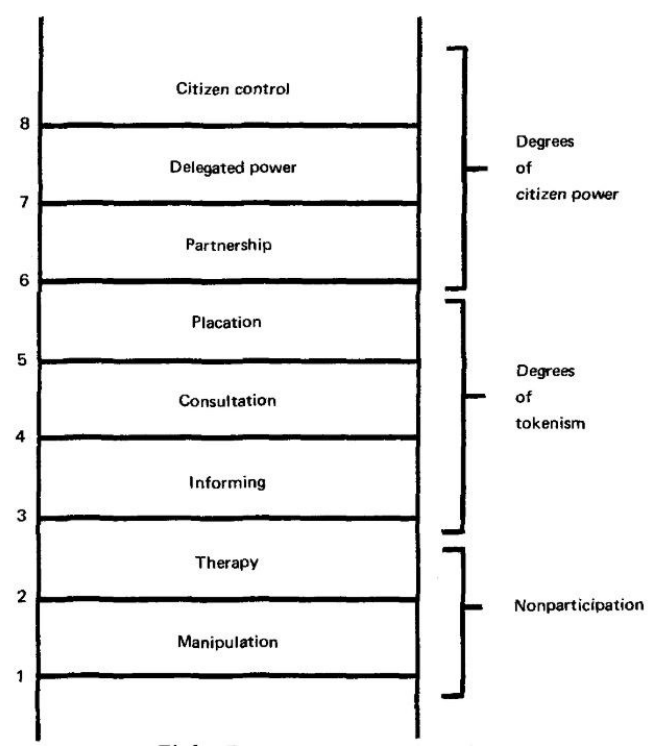
Figure 1 Arnstein’s eight rungs on a ladder of citizen participation (Arnstein,